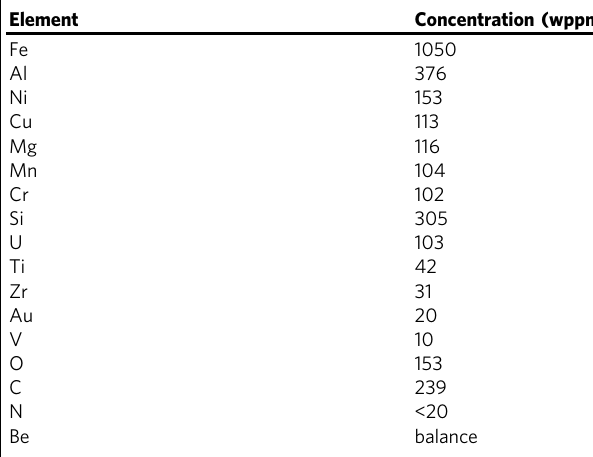
Table 2 Chemical composition of the irradiated 1 mm Be pebbles 68